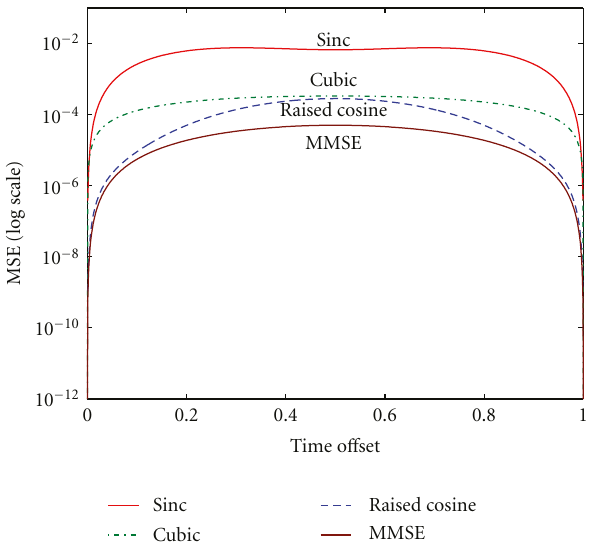
Figure 5: MSE versus time o ff set μ for M = 4 T s .